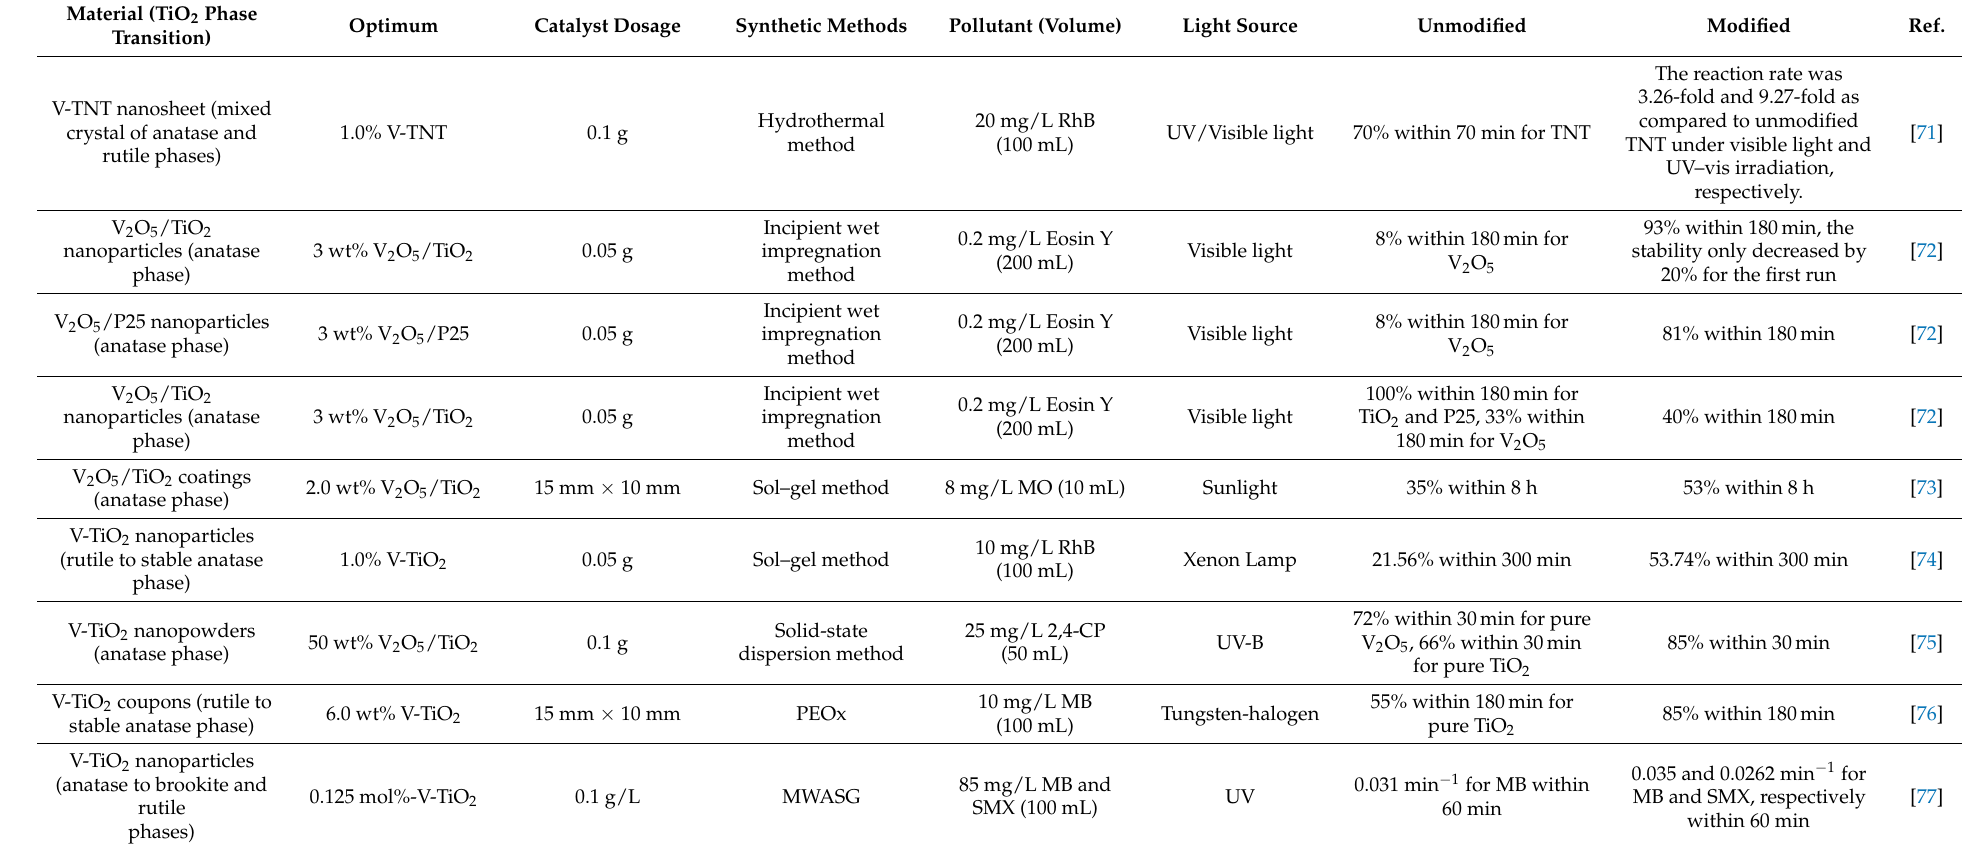
Table 3. Summary of recent progress on V-TiO 2 photocatalysts for organic pollutants